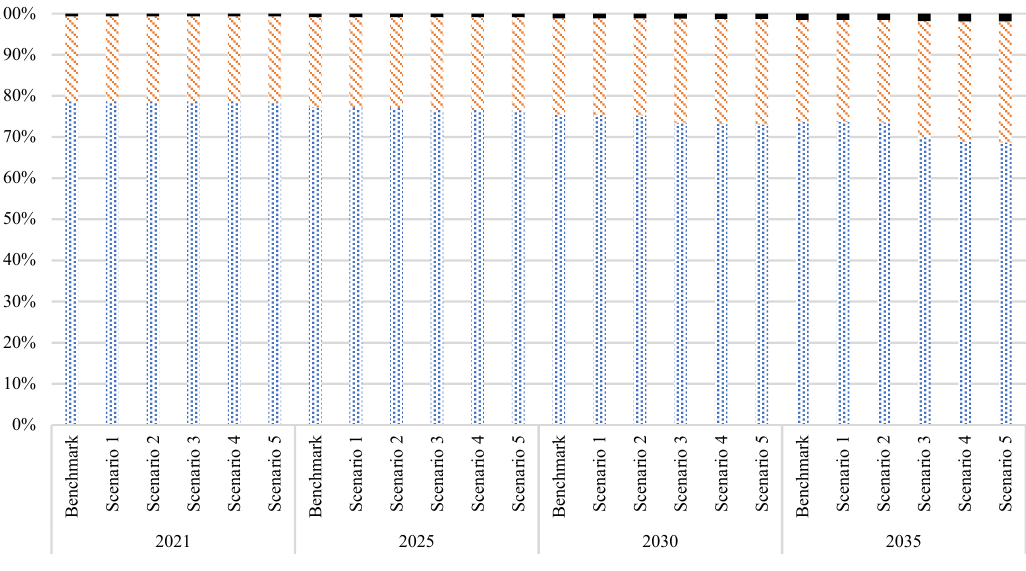
Figure 4. Carbon emissions composition of China’s energy consumption under different